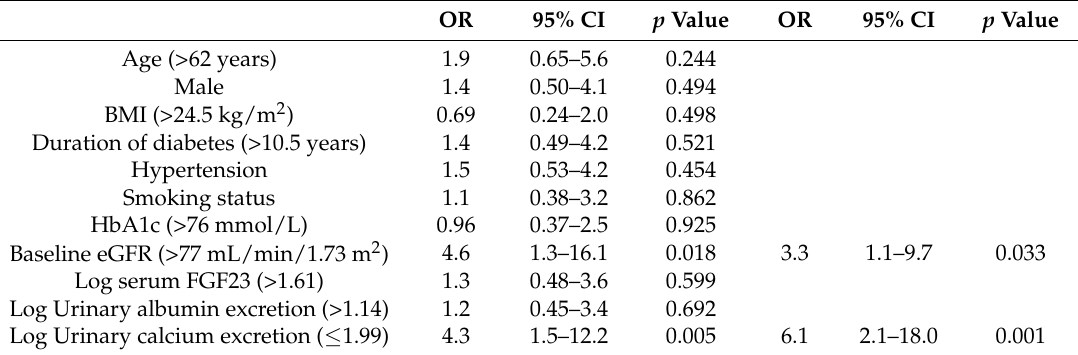
Table 2. Multivariate logistic analysis showing independent variables in progression of eGFR decline in patients with type 2 diabetes mellitus.